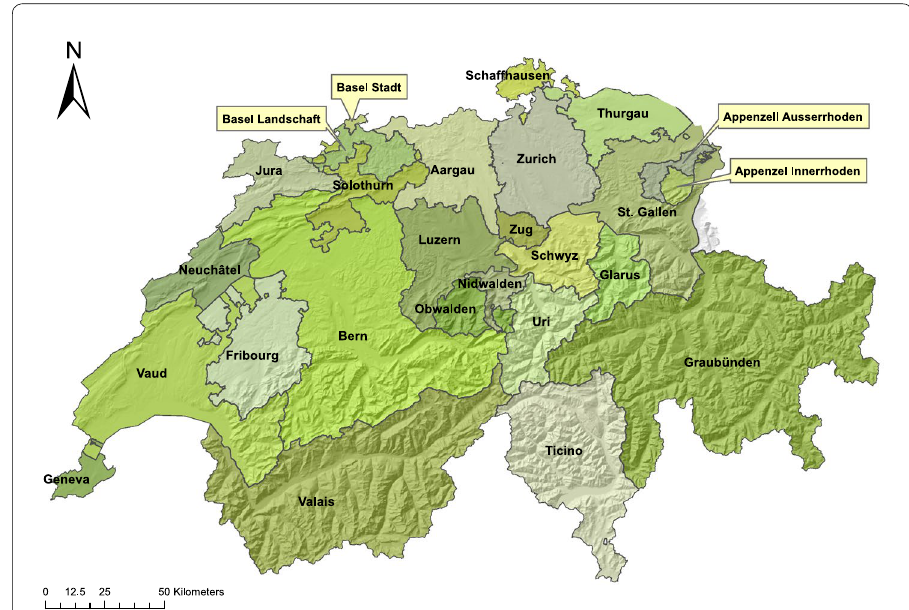
Fig. 18 The 26 Cantons of